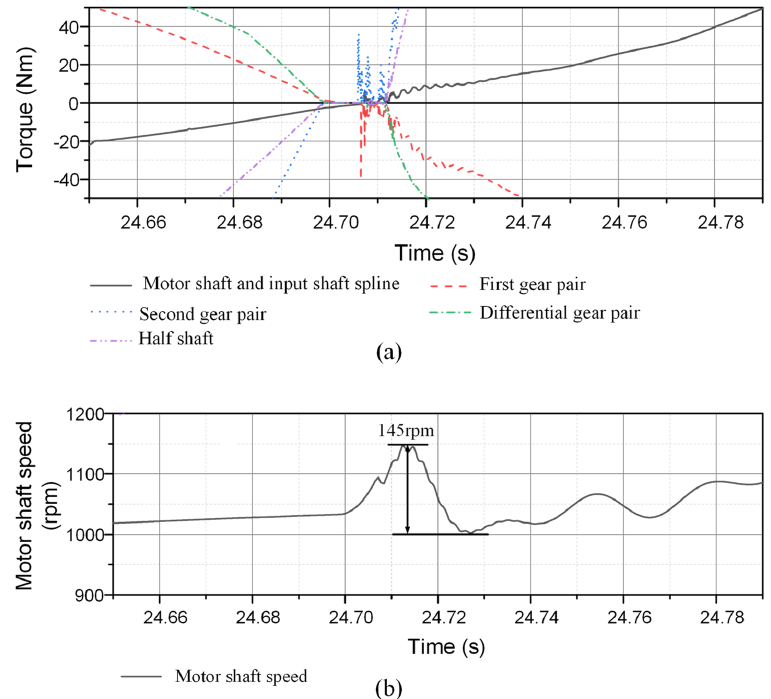
Figure 6. Responses of the torques and speed with the cumulative gap were halved. ( a ) Torque curves corresponding to the first and second-level meshing pairs. ( b ) Motor shaft speed).